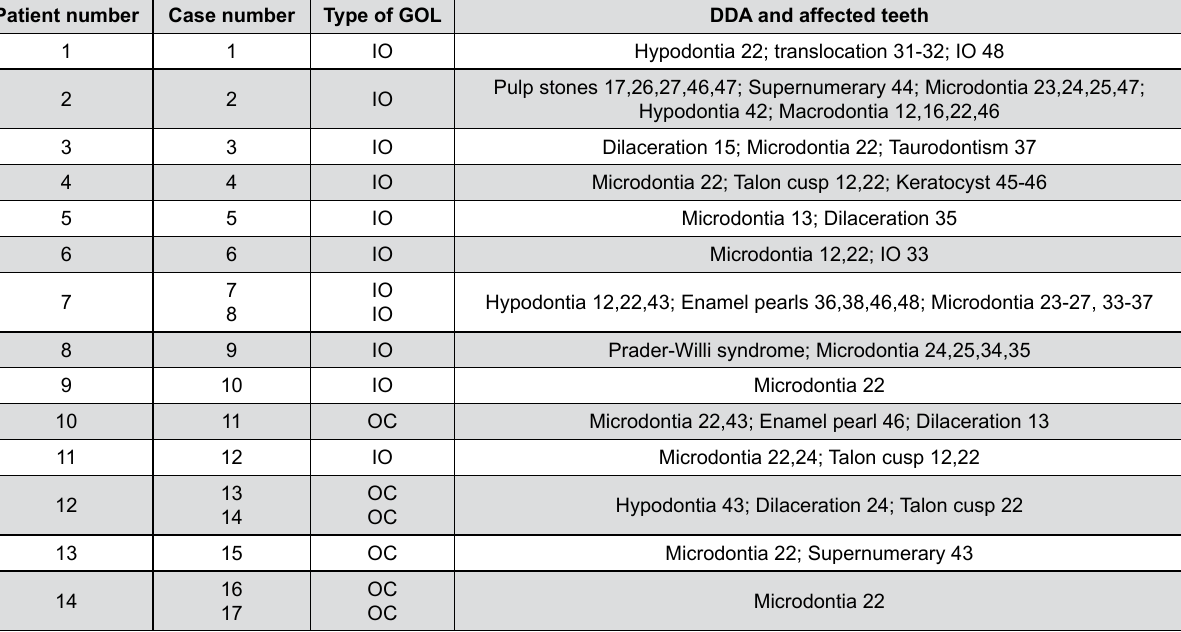
Figure 7- Patients with GOLs and dental developmental